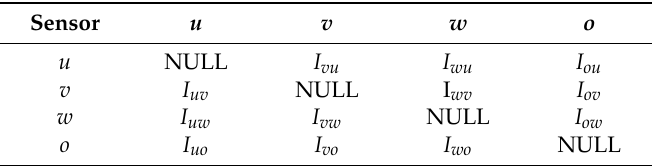
Table 1. Twelve computable inter-sensor data ratios